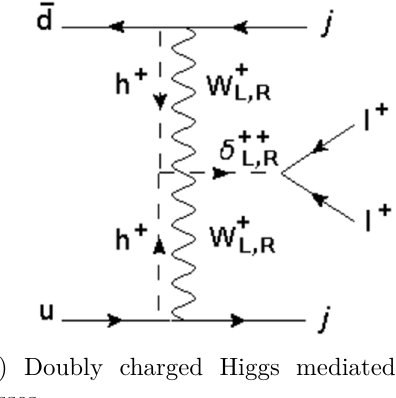
(a) Neutrino mediated processes. Figure 3. The t-channel processes leading to LSD + 2 jets signature. See also caption to figure 2.